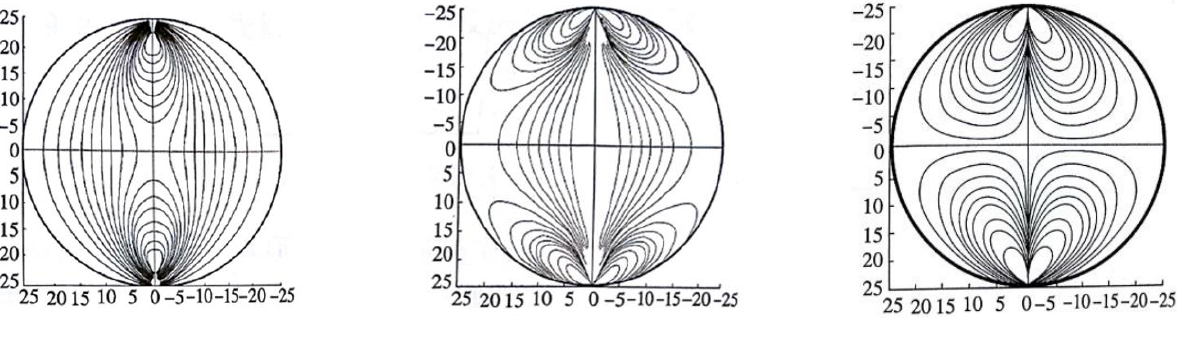
Figure 9. Distribution of stress in Brazil